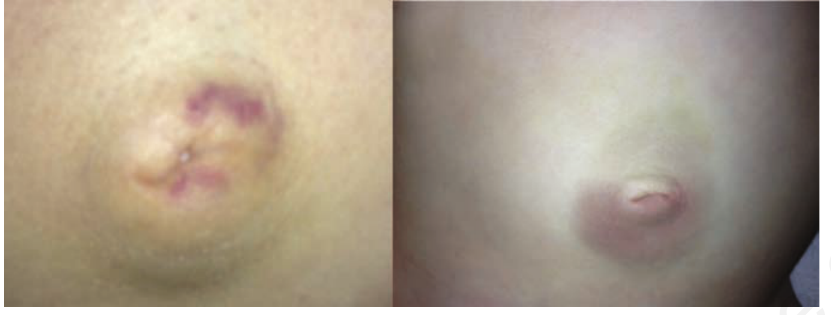
Figure 1. Umbilicus with bruises.